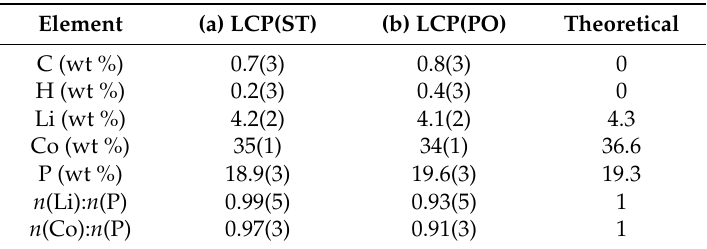
Table 1. Elemental analysis of LCP- Cmcm synthesized by (a) the solvothermal (ST) and (b) the polyol process (PO) 1,2